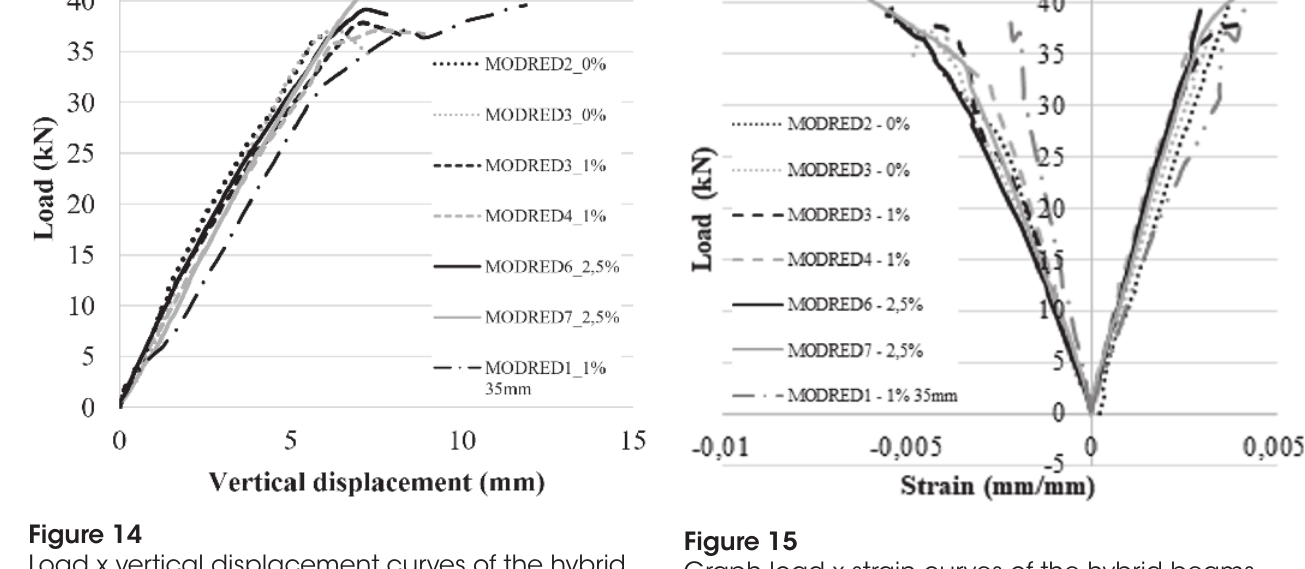
Graph load x strain curves of the hybrid beams (Author)